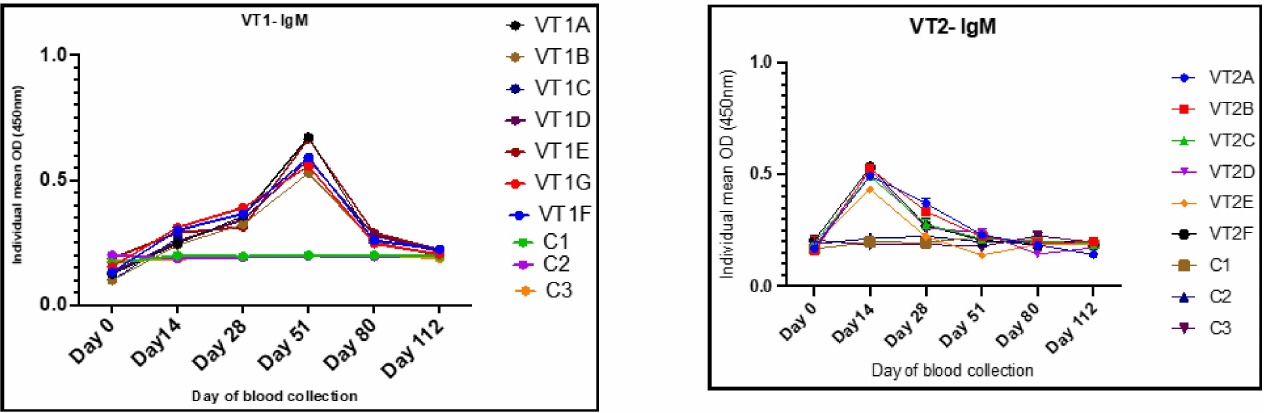
Figure 8. IgM responses on different time points in VT1- and VT2-immunized rabbits inoculated with 50 µ g and 100 µ g of antigen/animal, respectively. Different color dots represent mean of the individual animal (A-G) for immunized and C (1–3) for each control